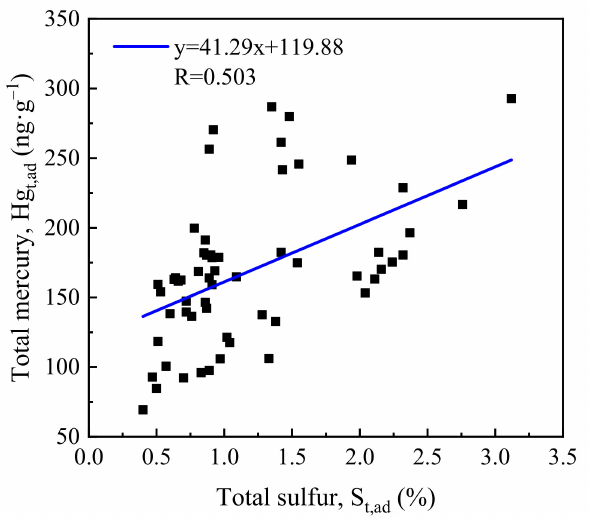
Figure 3. Correlation between Hg and total sulfur in 59 coal